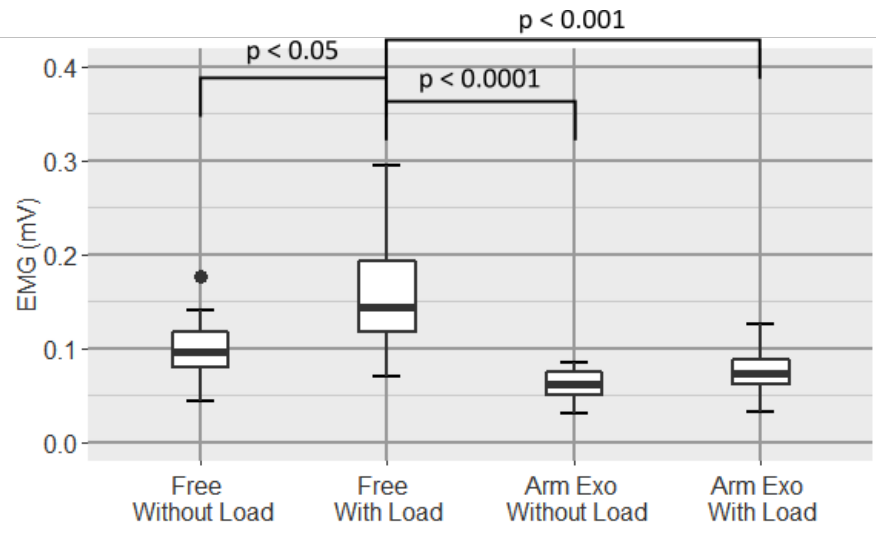
Figure 13. Boxplot of the EMG signal of the pectoralis major for all conditions.